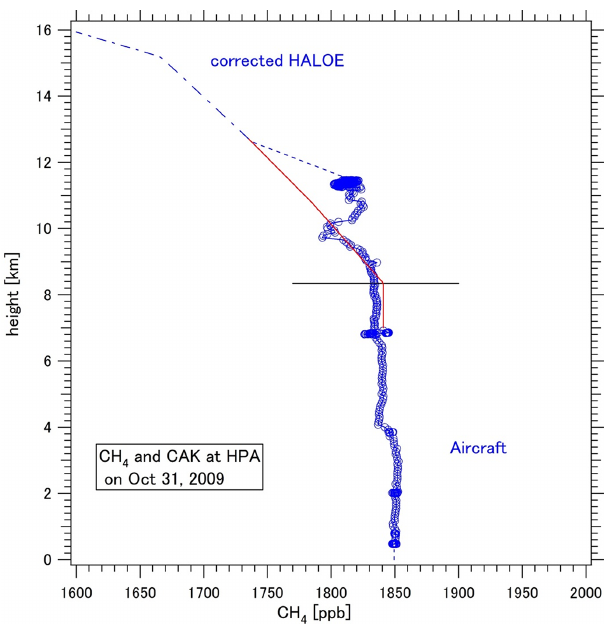
Figure 8. Vertical profiles of CH 4 over the northern part of Great Falls, Montana, obtained by the HIPPO mission (HPA) on 31 Octo- ber 2009. The black horizontal line shows the tropopause. The blue dash-dotted line indicates profile by ACE/corrected HALOE (in this case, corrected HALOE), and blue dashed lines indicate the profile assumed by linear interpolation or extrapolation. The blue solid line with blue open circles shows aircraft measurements, whereas the red line shows profile assumed when using only the aircraft mea- surement data over a limited altitude range below 7km (see